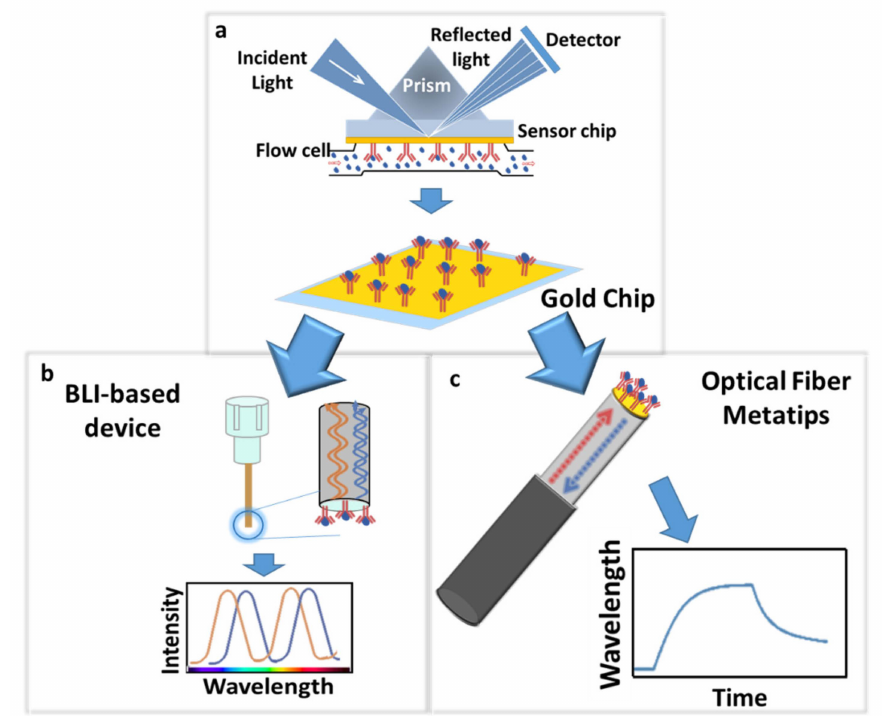
Figure 1. Schematic representation of the exploited approach: biofunctionalization protocol opti- mization using a gold chip (GC)-based mSPR device ( a ) and its successive transfer to a BLI-based platform that exploited a plastic optical fiber (ARG2 biosensor) ( b ) and a LoF platform based on a highly sensitive OFMT ( c ) for Cripto-1 detection